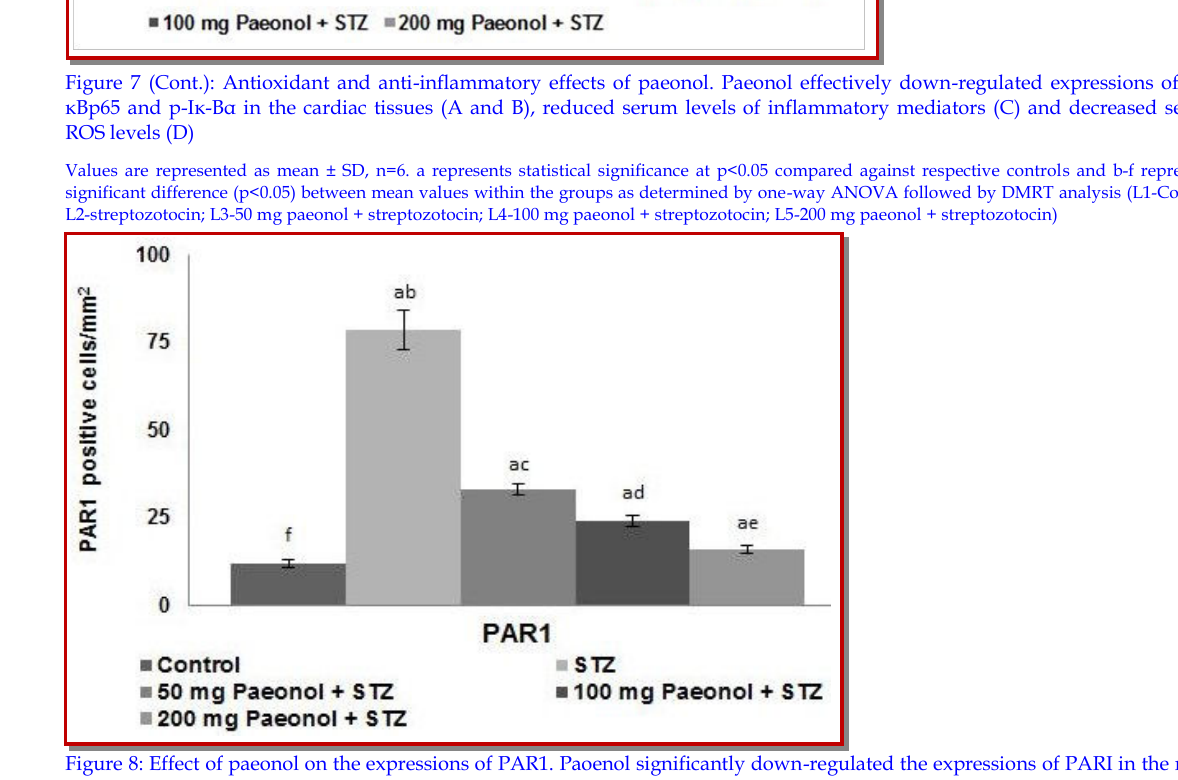
Figure 8: Effect of paeonol on the expressions of PAR1. Paoenol significantly down-regulated the expressions of PARI in the myo- cardial tissues Values are represented as mean ± SD, n=6. a represents statistical significance at p<0.05 compared against respective controls and b-f represents significant difference (p<0.05) between mean values within the groups of same cell line as determined by one-way ANOVA followed by DMRT analysis